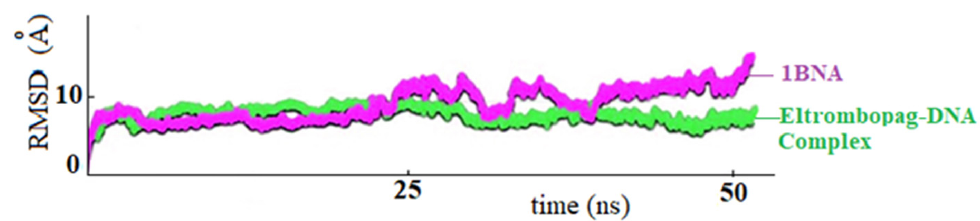
Figure 13. RMSD plots of ELT-BNA complex (in green) and non-ligand bound 1-BNA (in purple), respectively.